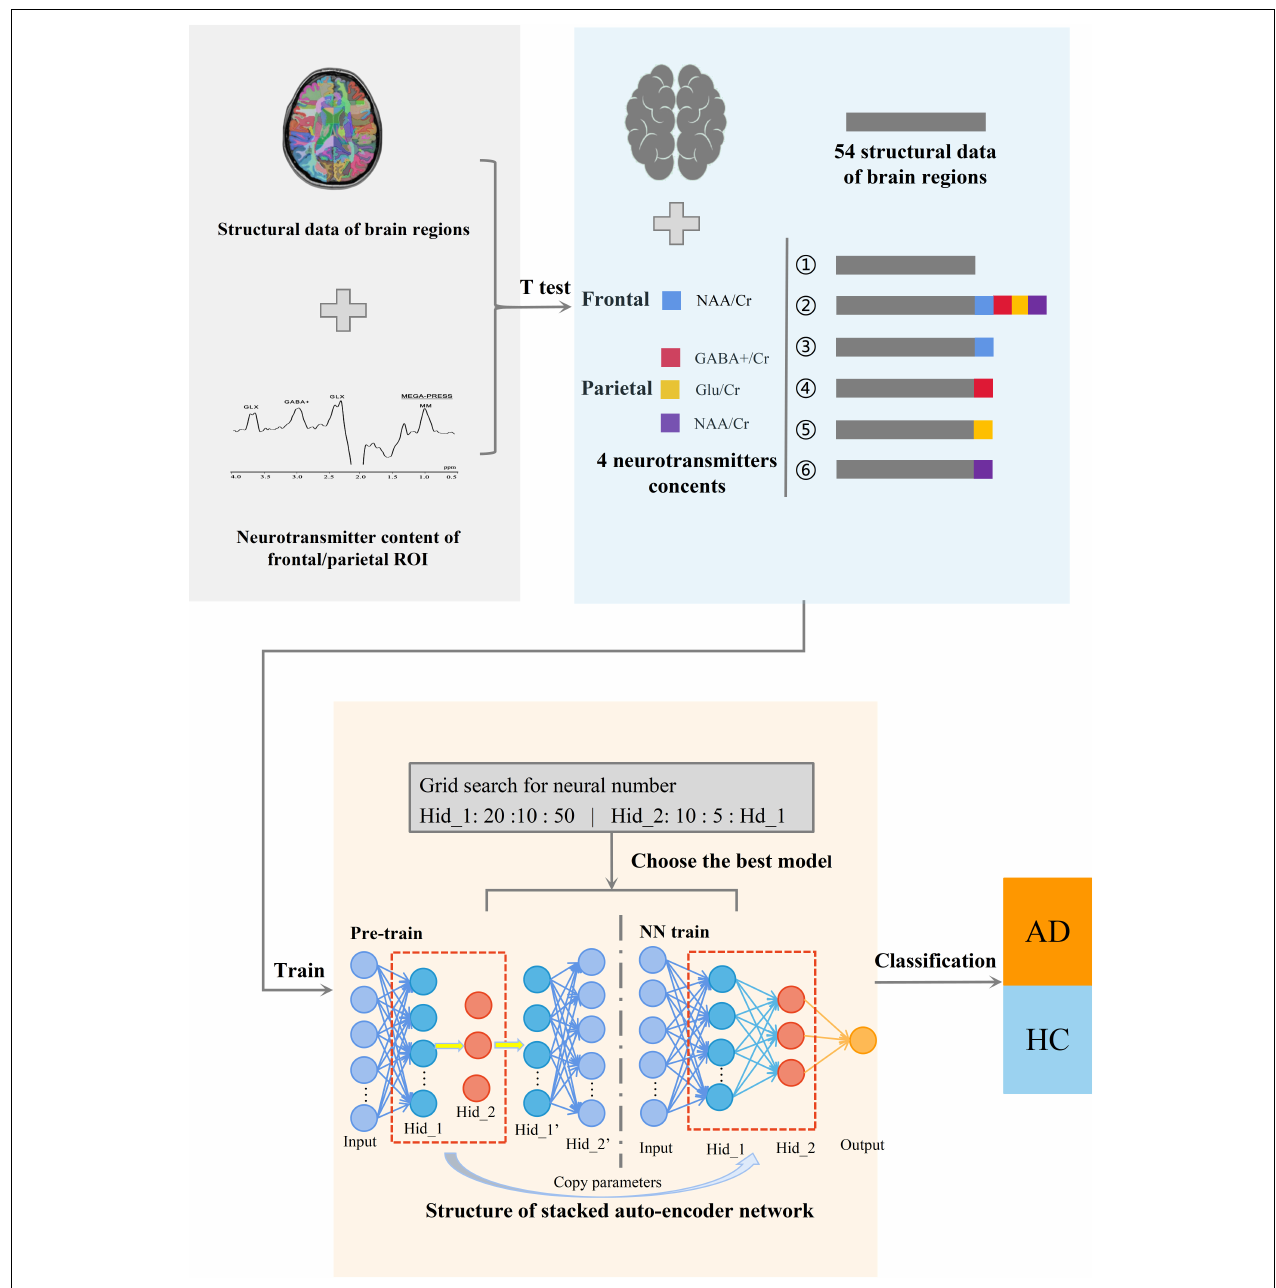
FIGURE 1 | Diagram of the overall structure of the classification model. The whole is divided into three parts, from left to right, the first part is to collect the structural data of brain regions and metabolite levels of the ROI in the frontal and parietal region. The second part is to carry out multi-model data processing of the obtained data. And the third part is to classify AD using SAE neural